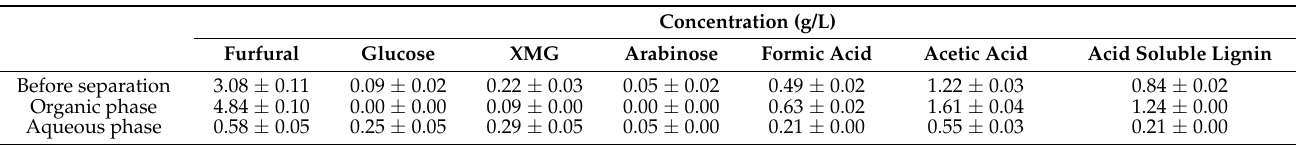
Table 6. Concentration of chemicals in furfural produced liquor prior to and after phase separation (organic phase, aqueous phase) through the addition of NaCl.